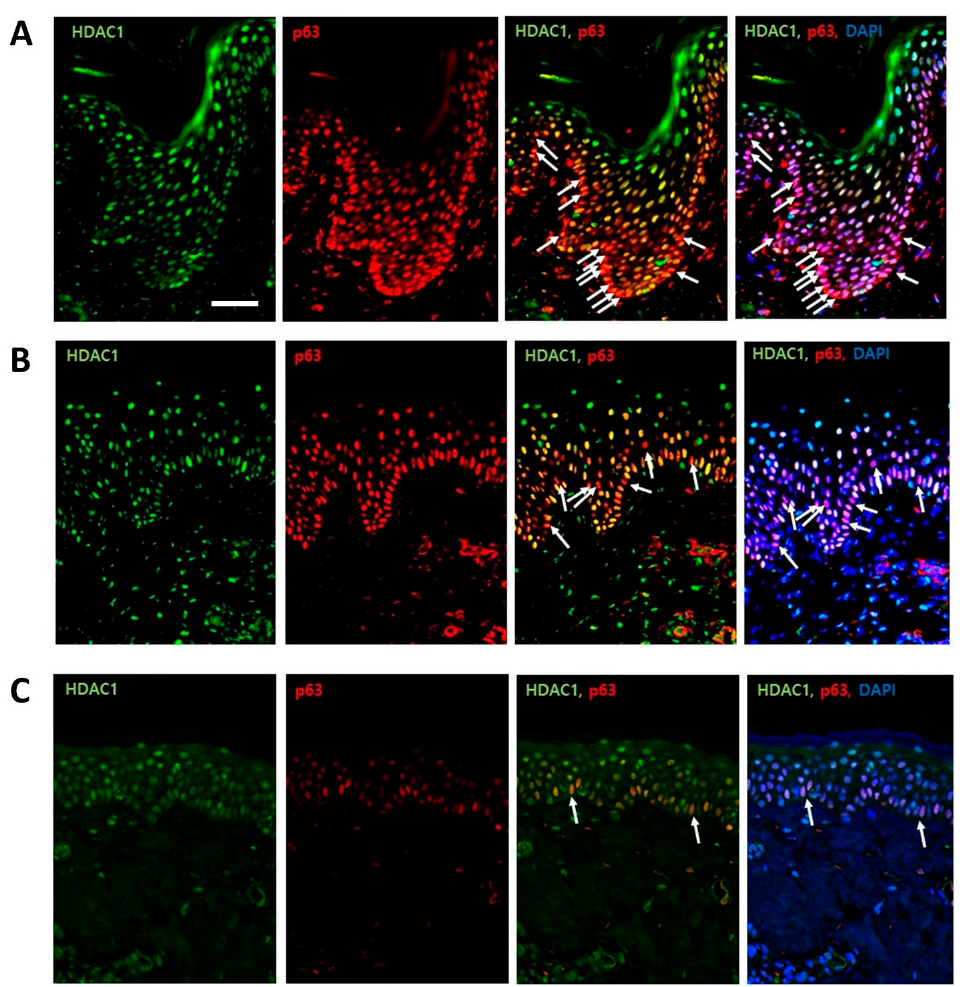
Figure 1. HDAC1 and p63 expressions in normal human skins. ( A ) HDAC1 and p63 expressions in the young-age group; ( B ) HDAC1 and p63 expressions in the middle-age group; ( C ) HDAC1 and p63 expressions in the old-age group. In a merged image, there was a minor subpopulation of cells with p63-positive/HDAC1-negative staining pattern in the basal layer (white arrow). The number of p63- positive and HDAC1-negative cells was decreased with age. (Green: HDAC1 staining, red: p63 staining, ×200, scale bar is 50 μ m).